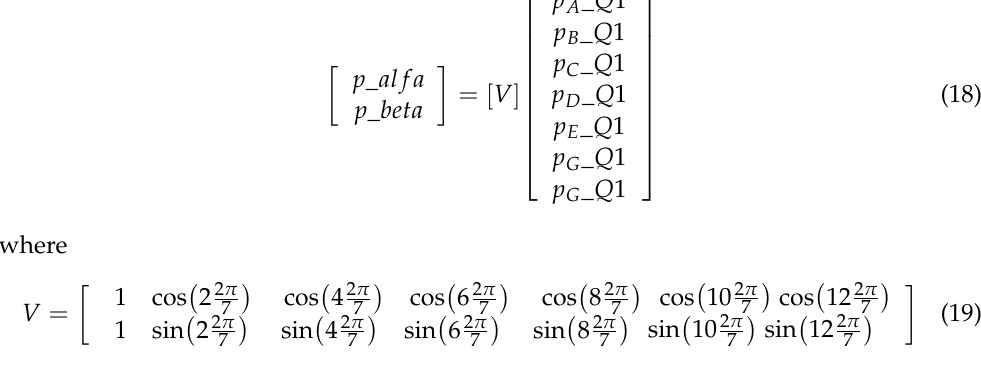
Table 3. Saliency position scalars in each sector of the seven-phase PMSM using Q 1 (case = 0). Sector